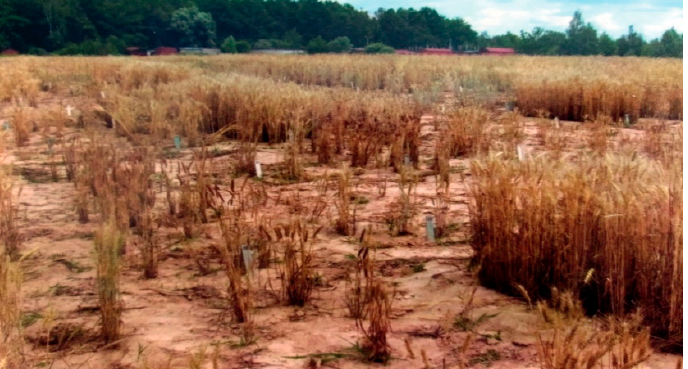
Figure 1. Surviving winter wheat cultivars after abiotic stress (winter hardiness) .